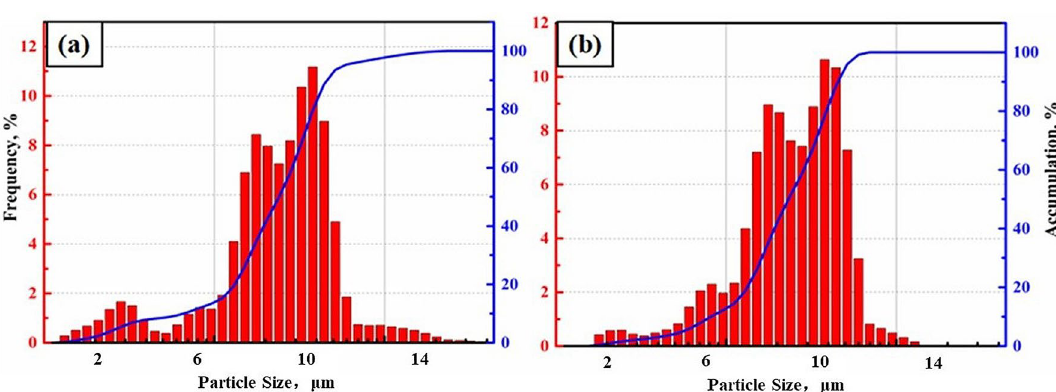
Figure 11. Particle size distribution of niobium powder before and after oxygen reduction: ( a ) before pickling and ( b ) after